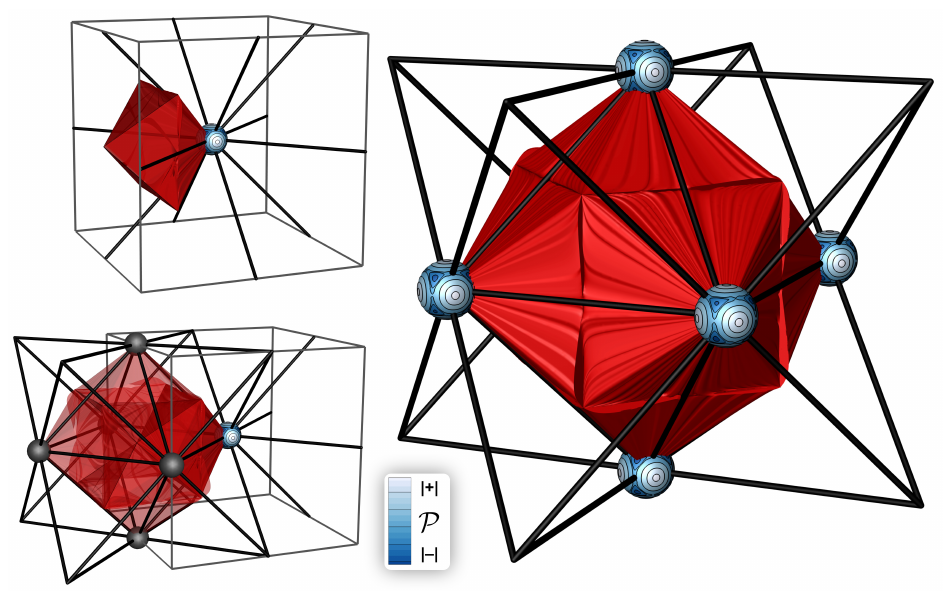
Figure 2. One Ag bond wedge is shown alone at top left, which combines to form a six-center bond bundle which coincides with the octahedral